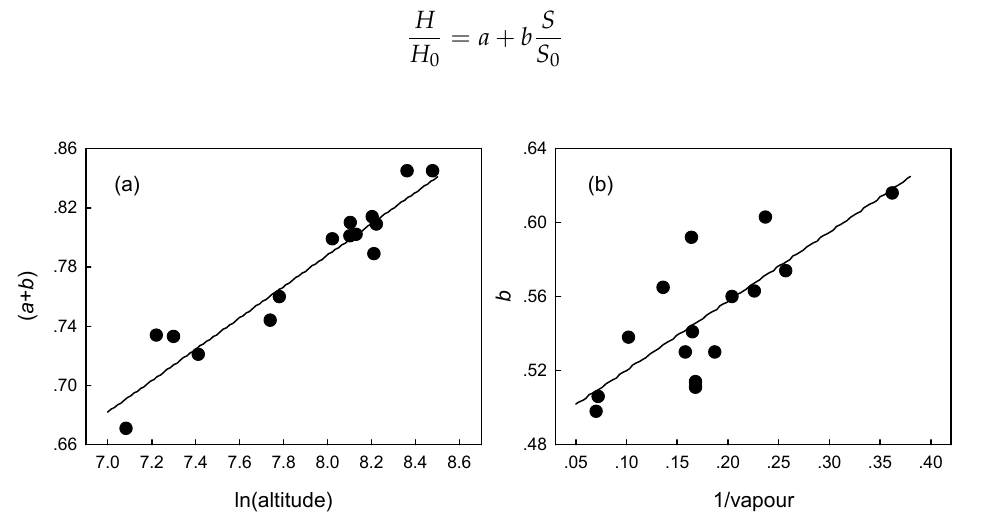
Figure 4. Relationship between coefficients in the Ångström model and the leading factors related to ( a ) altitude (m), and ( b ) water vapor pressure (hPa).